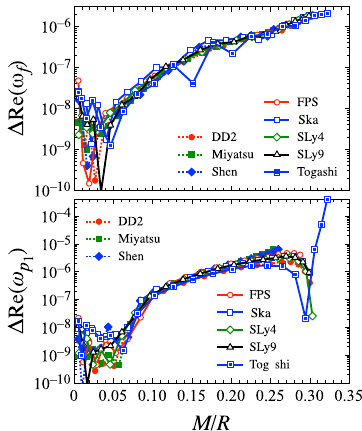
Fig. 6 The relative deviation of the value of ω r determined with the zero-damping approximation from the value of Re (ω) determined through the proper eigenvalue problem without the approximation, which is calculated with Eq. (6), is shown as a function of M / R for various neutron star models. The top and bottom panels correspond to the results for the f - and p 1 -modes, respectively